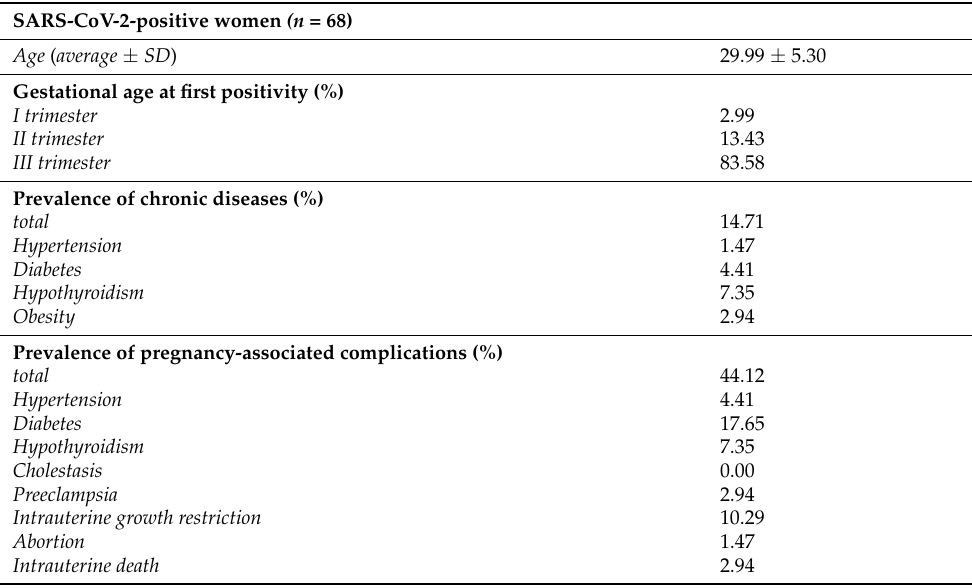
Table 1. General characteristics of SARS-CoV-2-positive pregnant women enrolled in the study and their